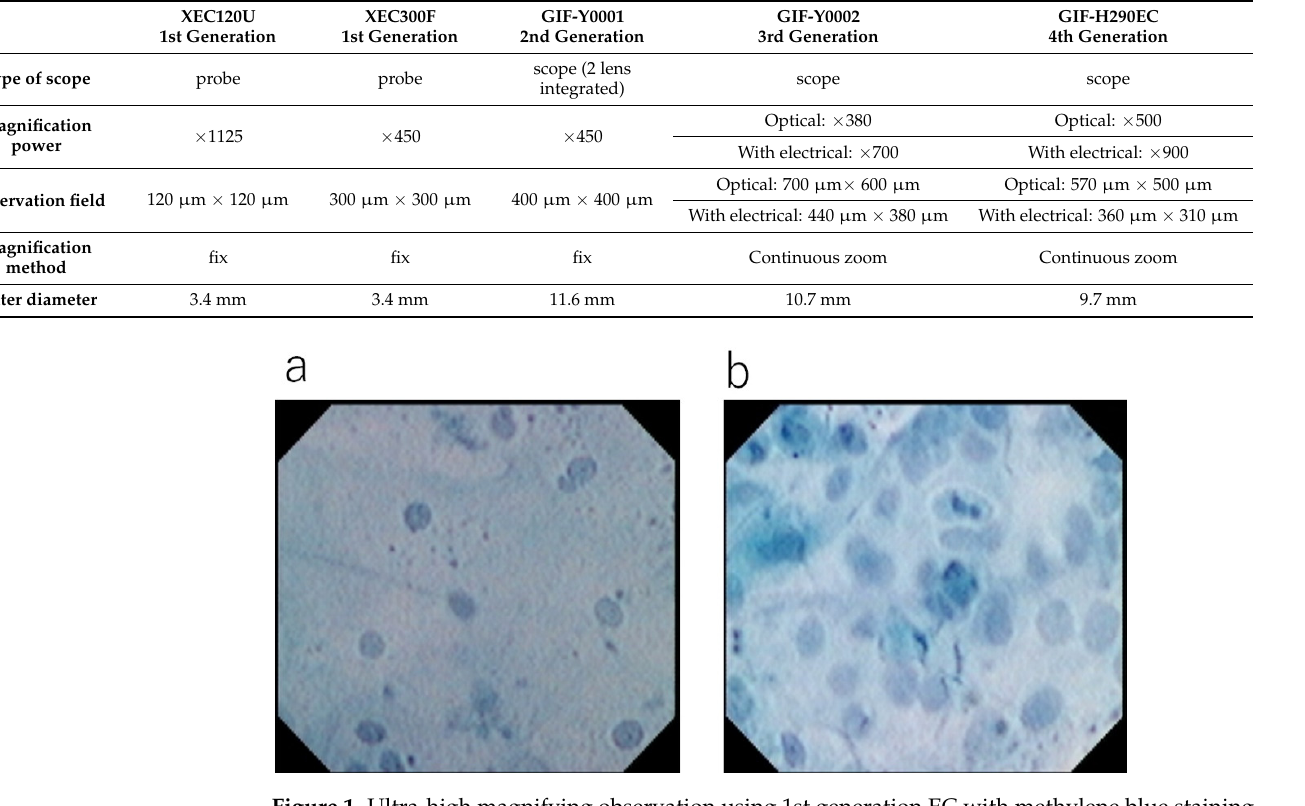
Figure 1. Ultra-high magnifying observation using 1st generation EC with methylene blue staining (XEC120U 1125x Olympus Medical systems Co., Tokyo, Japan): ( a ) Normal esophageal mucosa. Surface epithelial cells have a low nuclear/cytoplasm ratio and no nuclear abnormality. ( b ) Esophageal squamous cell carcinoma. Cancerous cells show an increase in nuclear density in comparison with the normal squamous epithelium and have prominent nuclear abnormalities. Table 1. Four generations of endocytoscope.